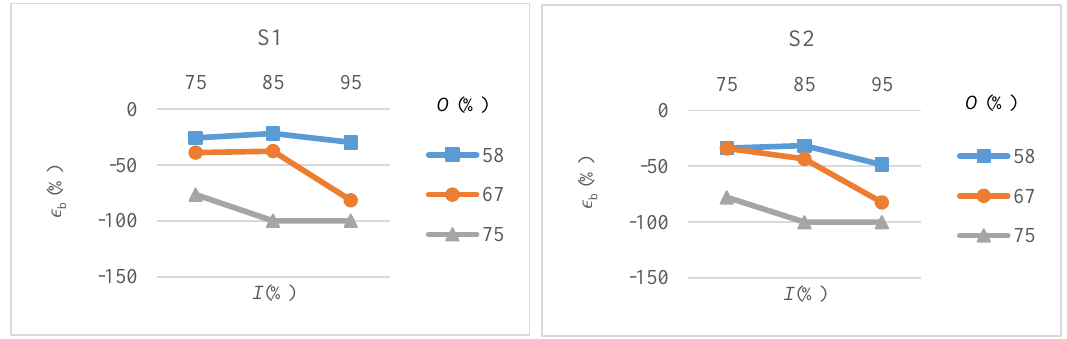
Figure 10. Bottom width error (𝜖 𝑏 ) as a function of intensity ( I ) and overlap ( O ) for scanning pattern S1 and S2.